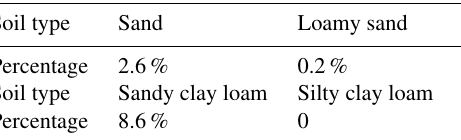
Figure B1. Free dust fraction for 12 soil types as a function of particle diameter ( d p ). The red lines represent the free dust fraction in WRF- Chem v3.8 and later versions. The blue lines represent the free dust fraction before WRF-Chem v3.8. The colors of the soil type font in the upper left corner of the plot are different. In WRF-Chem v3.8 and later versions, each soil type has a corresponding free dust fraction distribution. In versions before WRF-Chem v3.8, several soil types share a free dust fraction distribution. The same soil type font color indicates that a free dust fraction is shared among these soil types in versions before WRF-Chem v3.8. Table B2. Percentage of each soil type in the whole East Asia domain.